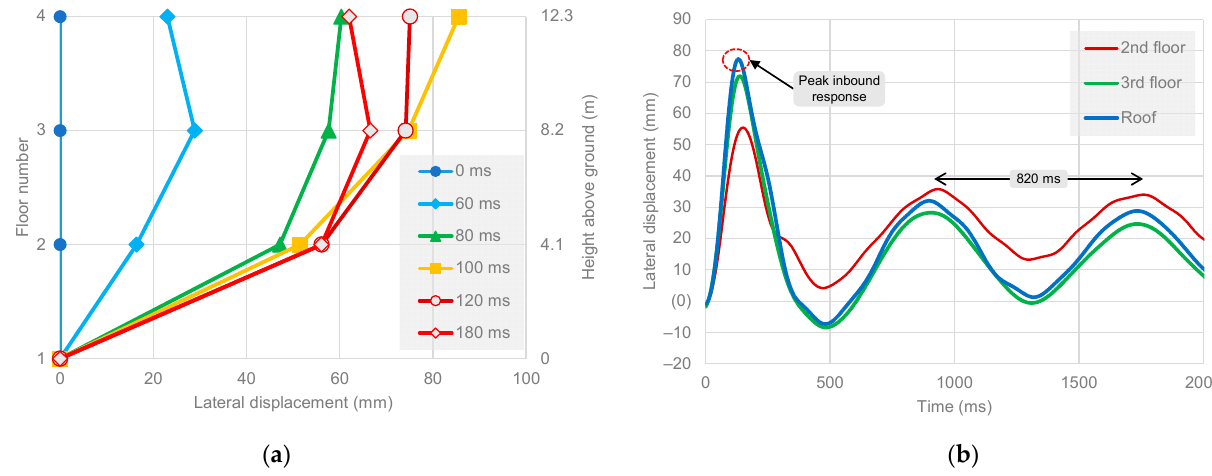
Figure 20. Test 2—Lateral response of structure: ( a ) Deflected shape at different times; ( b ) Lateral deflection history and estimation of natural period, data from DG4, DG5, and DG6.